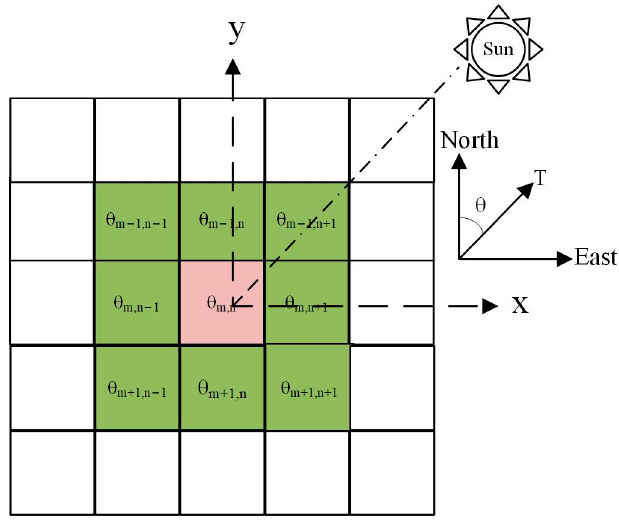
Figure 5. DEM grid data diagram.